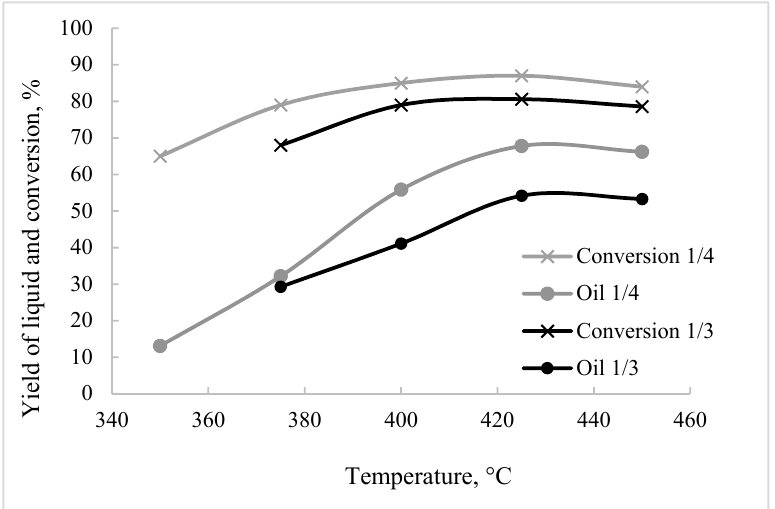
Figure 6. Effect of temperature and dilution with tetralin on biochar conversion and yield of liquid products.